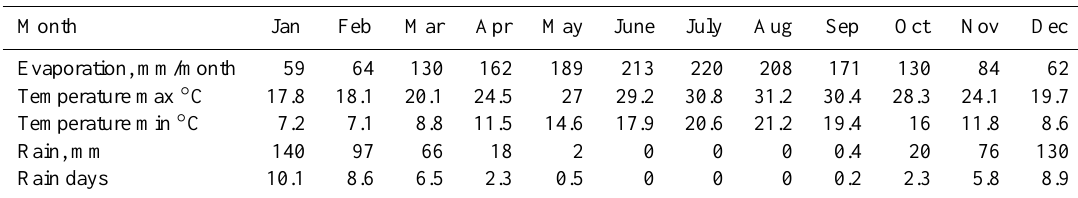
Table 1. Average climate data in the Ayalon basin. Note zero precipitation between May–September (Meteorological Service, Beit-Dagan station).